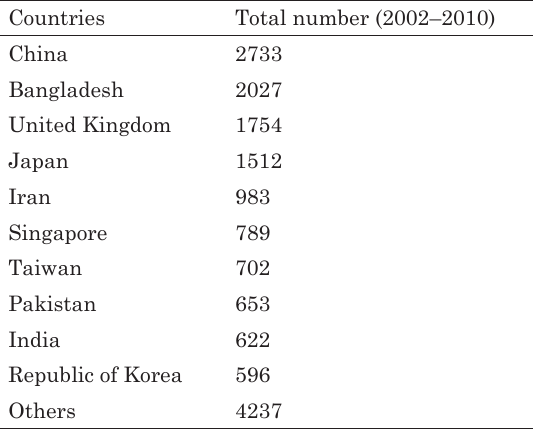
Table 1. Top 10 countries involved in MM2H